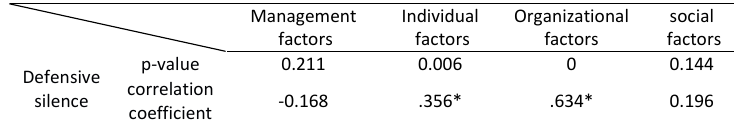
Table 8. The test of the correlation between defensive silence variables and silence factors